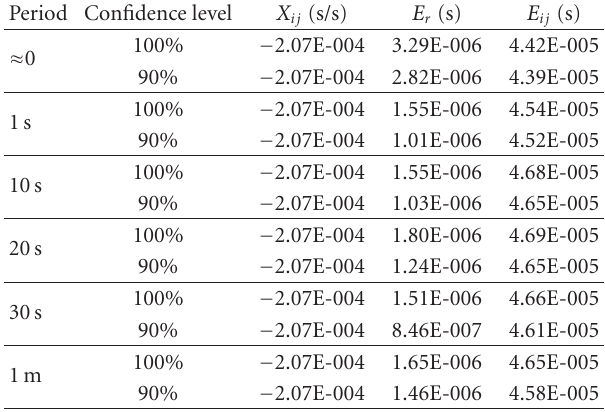
Table 3: Clock drift approximation according to several di ff erent